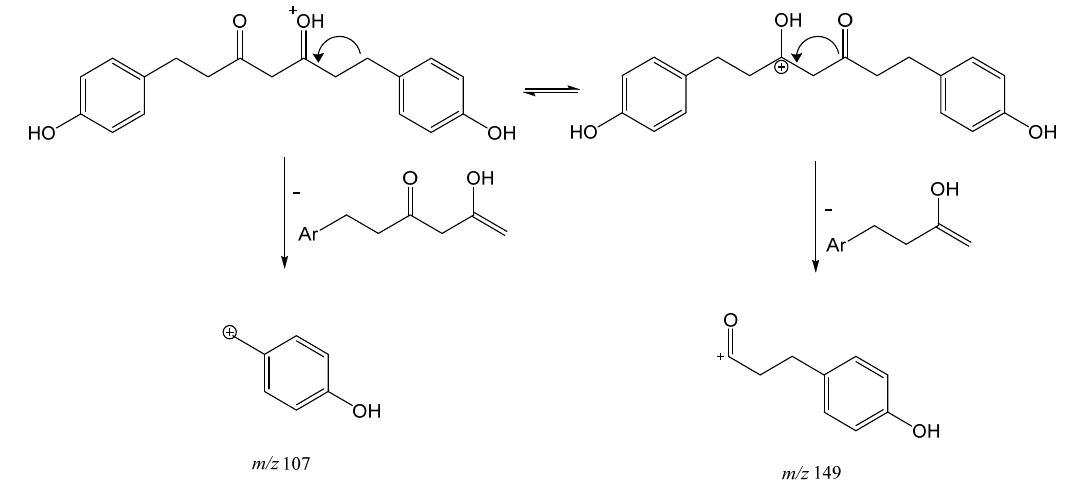
19 H 21 O 4 ), which was tentatively